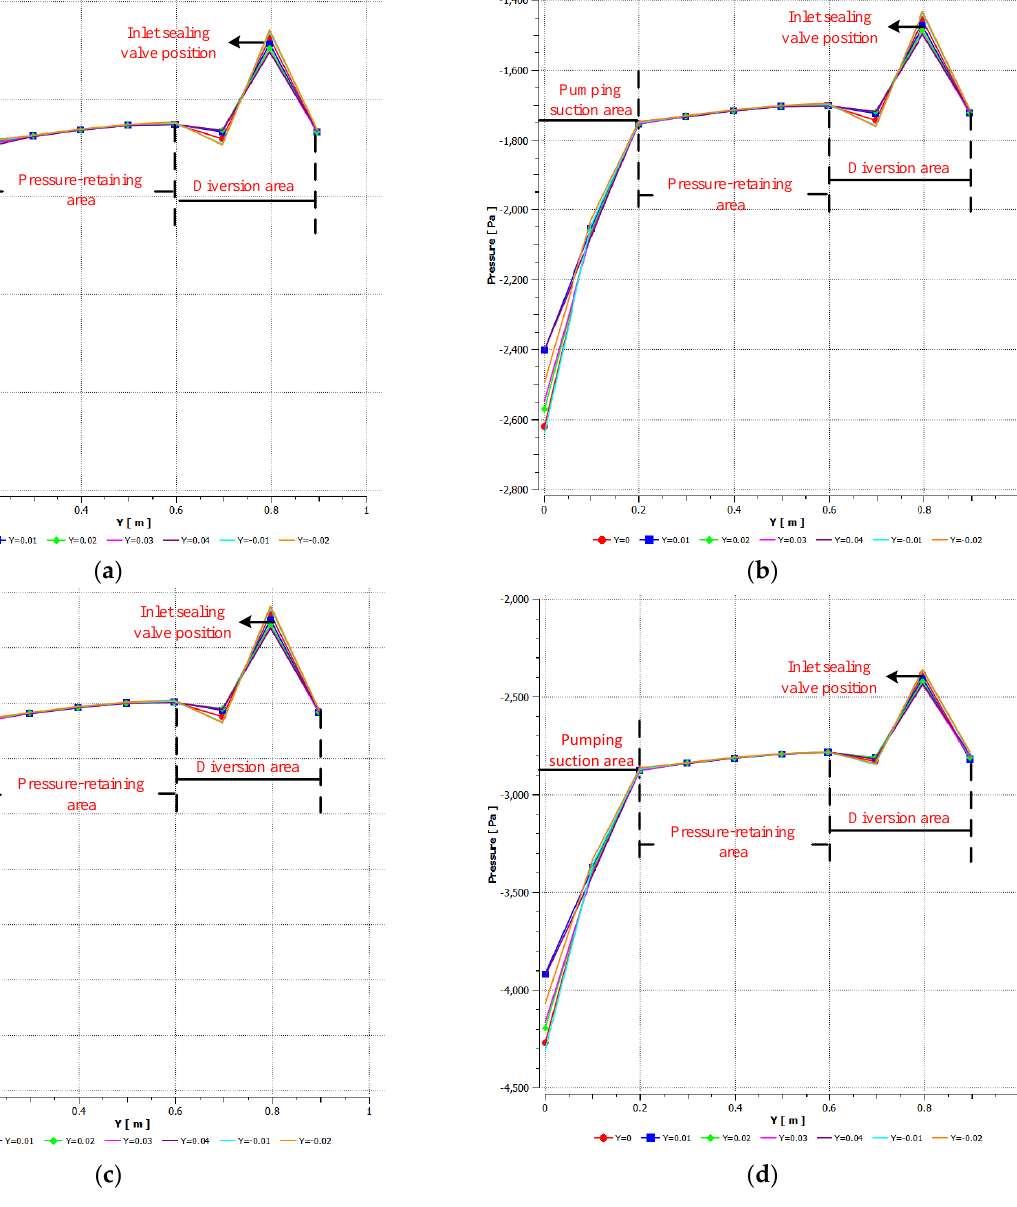
Figure 10. Radial pressure distribution of HSMPS. ( a ) 12 m 3 /h, ( b ) 14 m 3 /h, ( c ) 16 m 3 /h, ( d ) 18 m 3 /h.